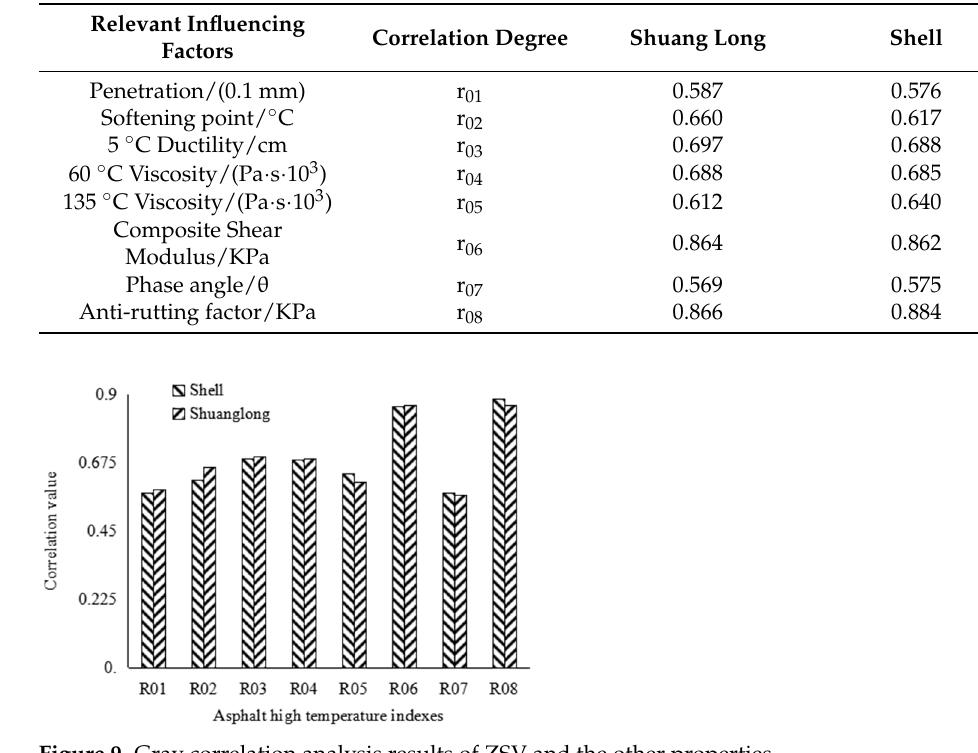
Figure 9. Gray correlation analysis results of ZSV and the other properties.